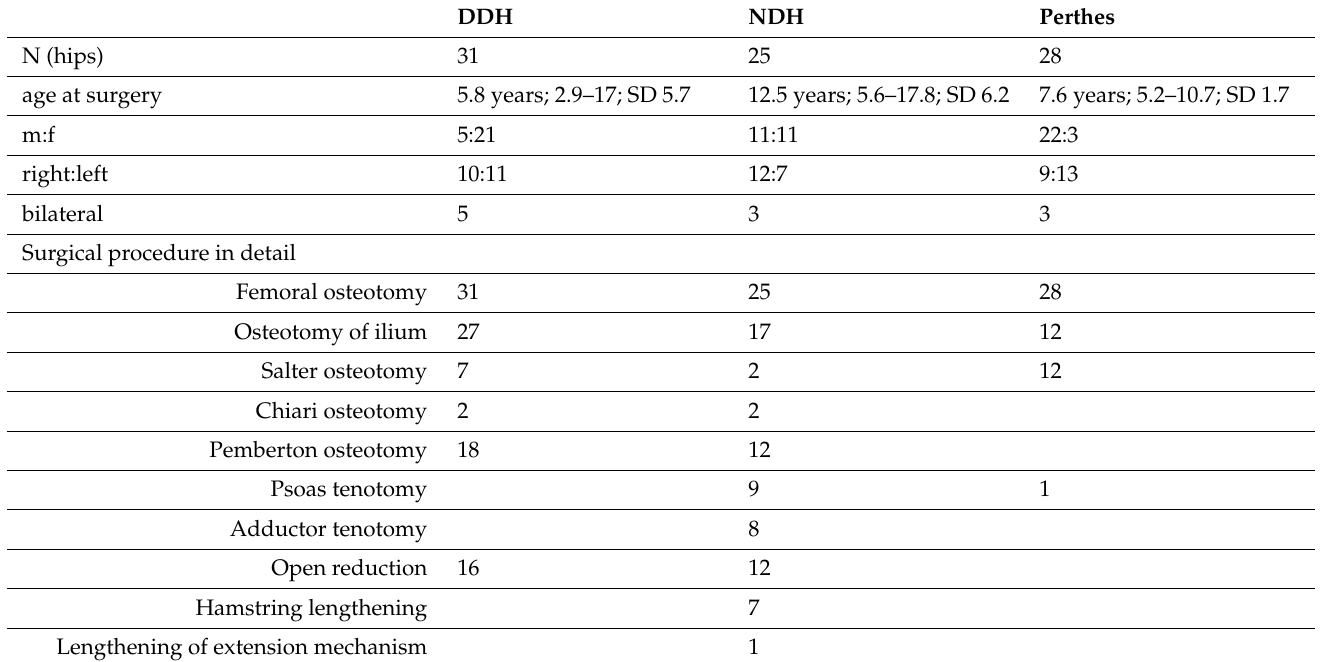
Table 1. Joints and surgical procedures [26].